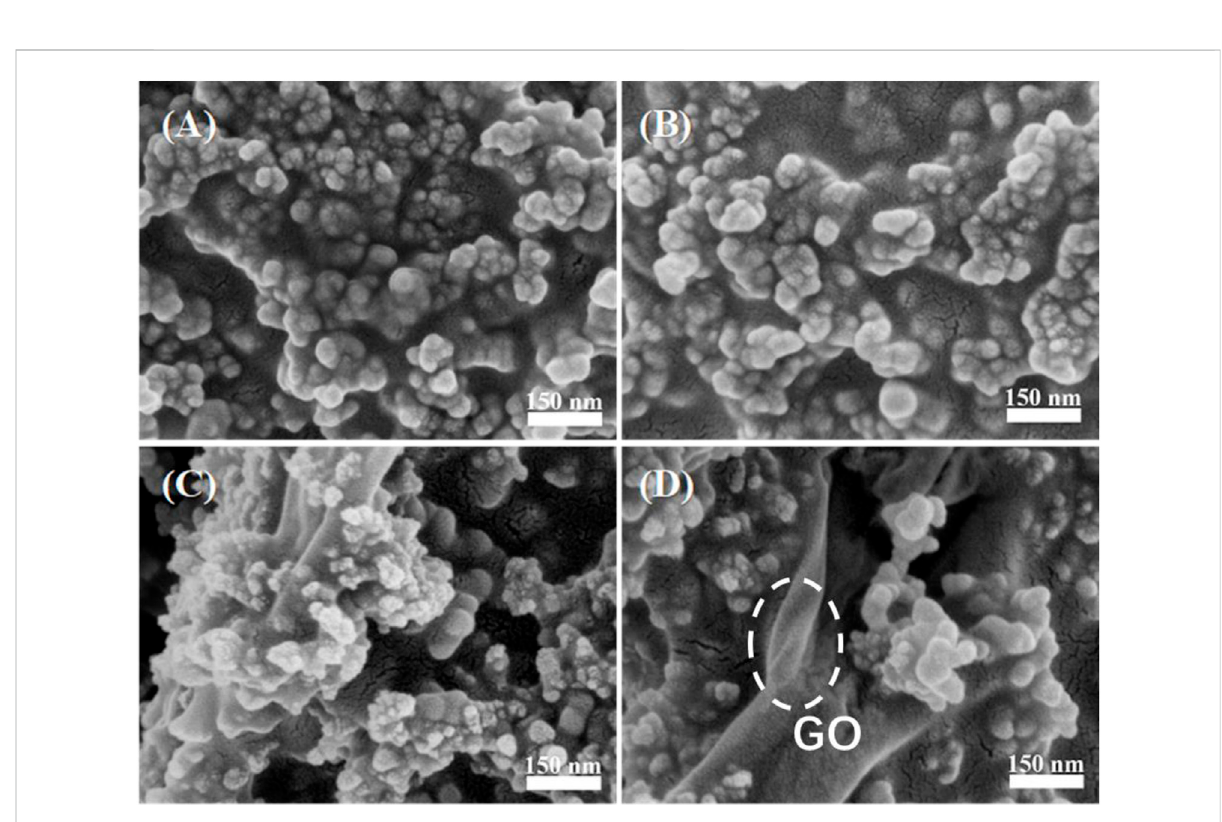
FIGURE 4 SEM images of composite coatings with 0.25 g SiO 2 NPs and different GO contents: 0.5 wt% (A) , 1% (B) , 1.5 wt% (C), and 2 wt%